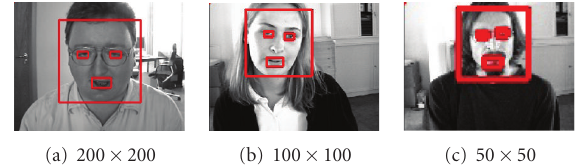
Figure 5: Facial component detection results for di ff erent resolu- tion faces from BioID database.